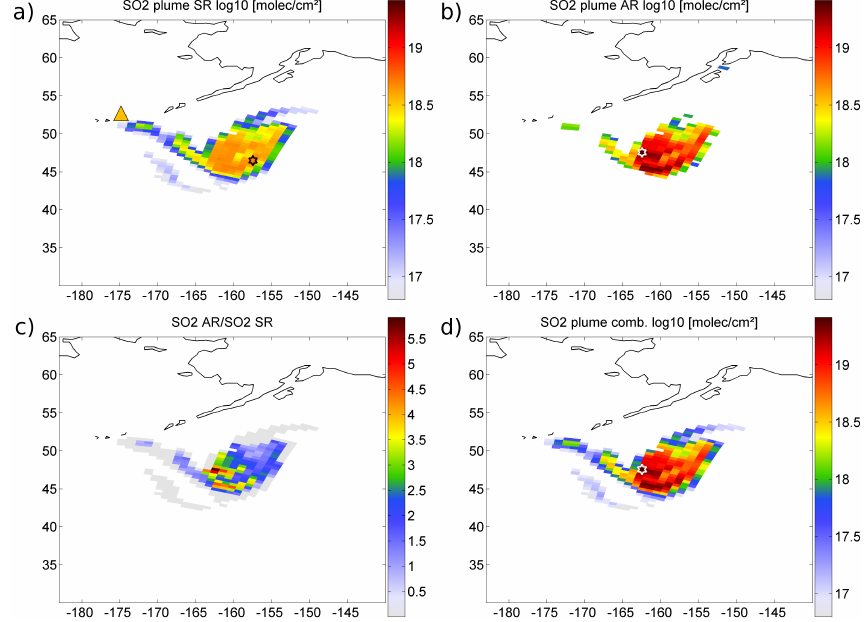
Fig. 4. Volcanic SO 2 plume as seen by GOME-2 on 9 August 2008 during the eruption of Kasatochi volcano. (a) SO 2 SCDs from the standard retrieval (312.1–324nm), (b) SO 2 SCDs from the alternative retrieval (326.5–335.3nm). While the maximum SO 2 SCD for the SR (5.2 × 10 18 moleccm − 2 ) is located in the southeastern part of the plume (indicated by a black hexagon), it is now found to be shifted towards the west with a 5 times higher SCD (2.7 × 10 19 moleccm − 2 ) in the AR (white hexagon). (c) Ratios between the SO 2 SCDs from the alternative and standard retrieval (d) The new SO 2 SCD product combines the results from both retrievals. Note the logarithmic scale in (a) , (b) and (d)